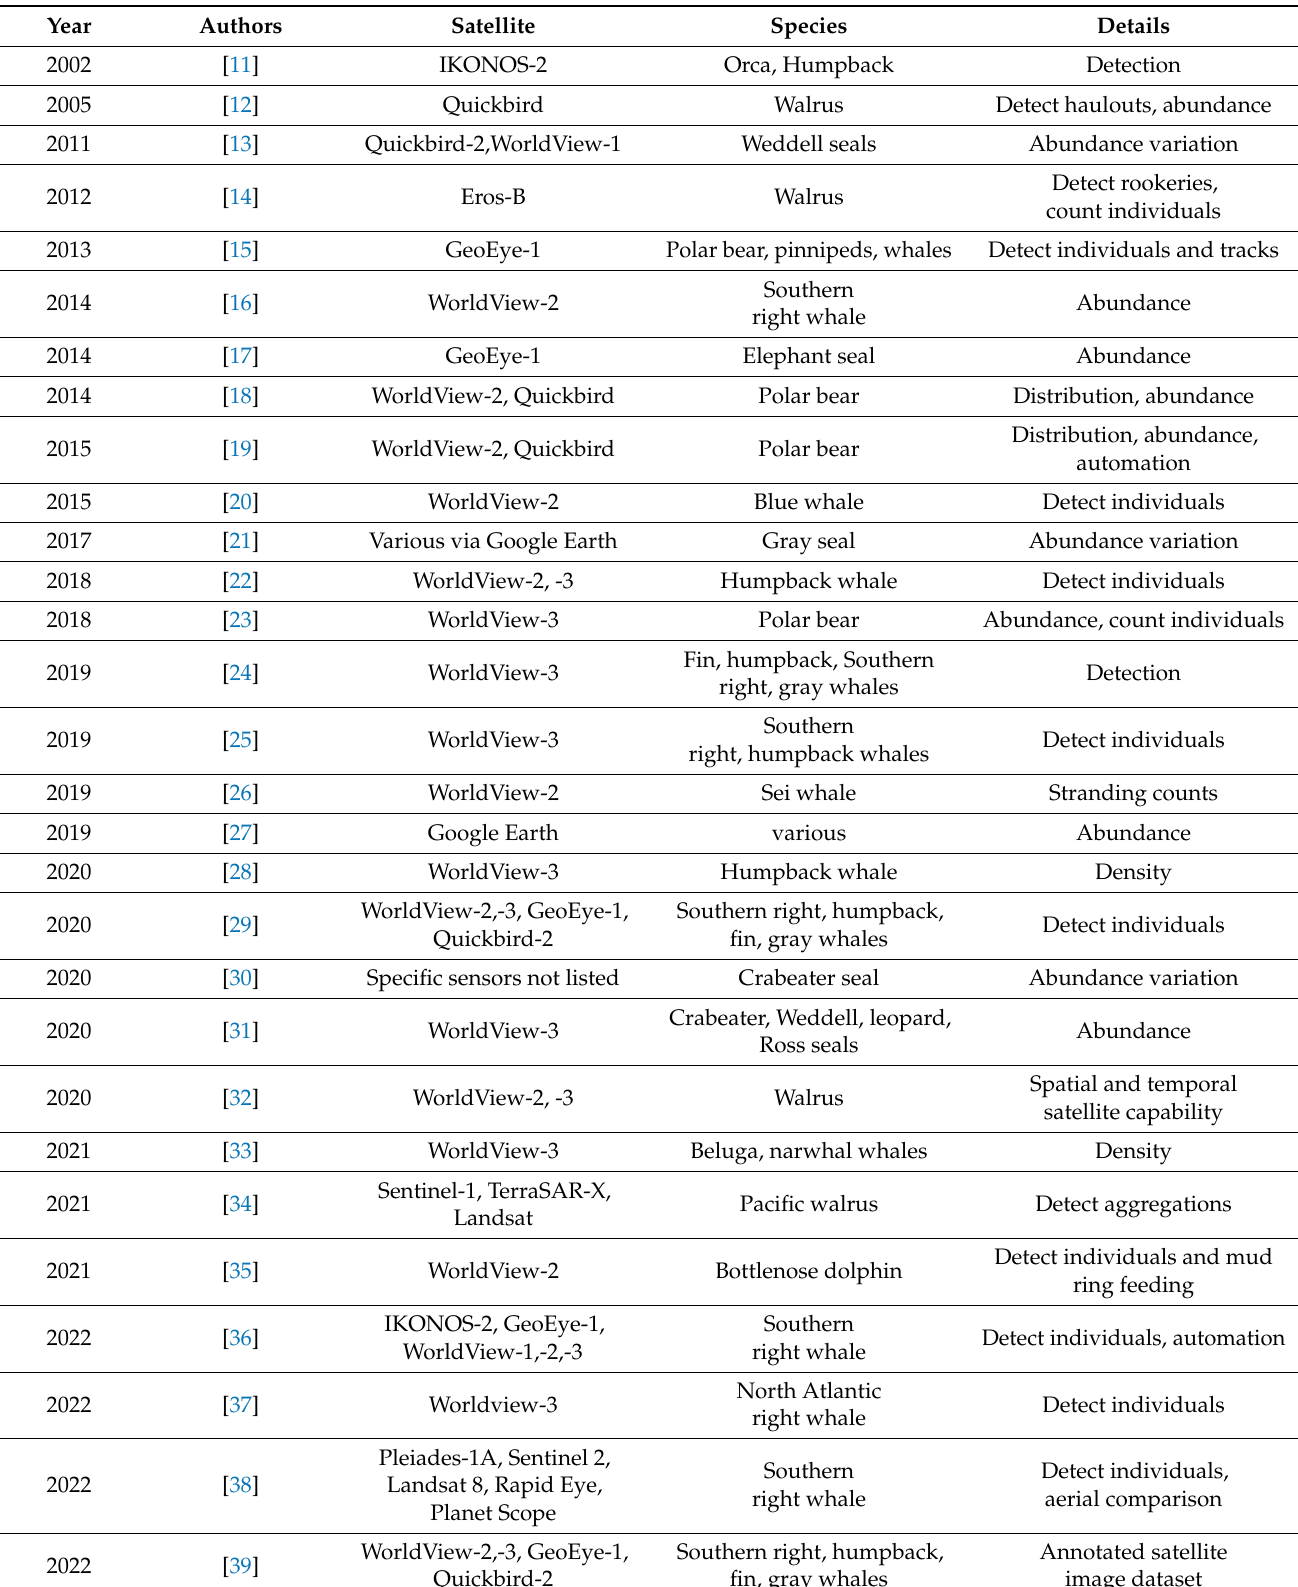
Table 1. Summary of publications that have used satellite imagery to detect marine